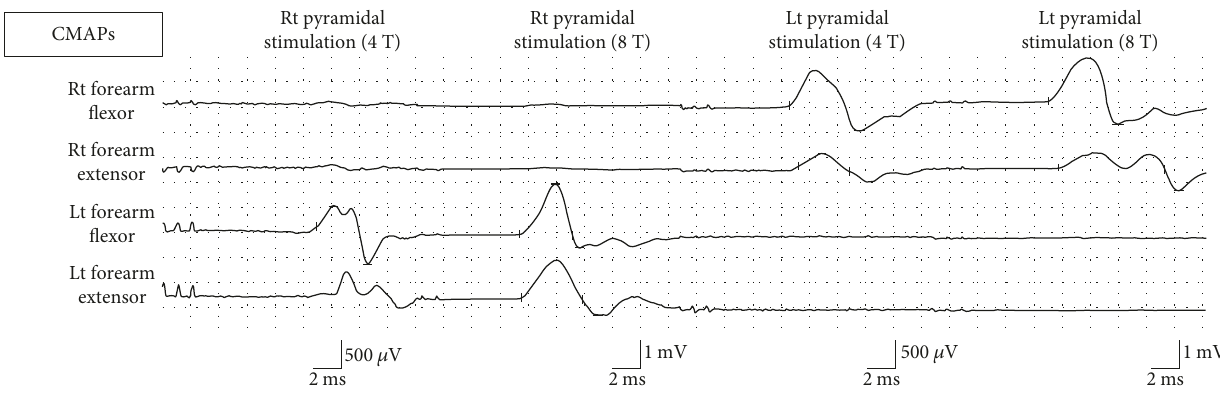
Figure 6: CMAPs obtained by stimulating the pyramid of the rats for preliminary experiment. Despite the increase in stimulation intensity from 4 T to 8T for both the left and right pyramids, no ipsilateral CMAPs were recorded.